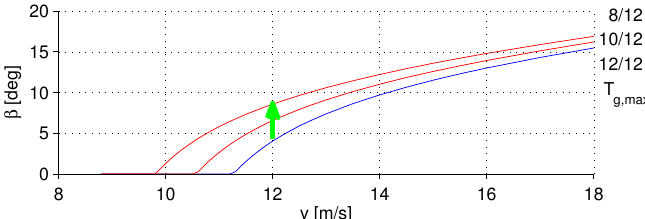
Figure 7. Stationary pitch angle values in the full load region dependent upon number of